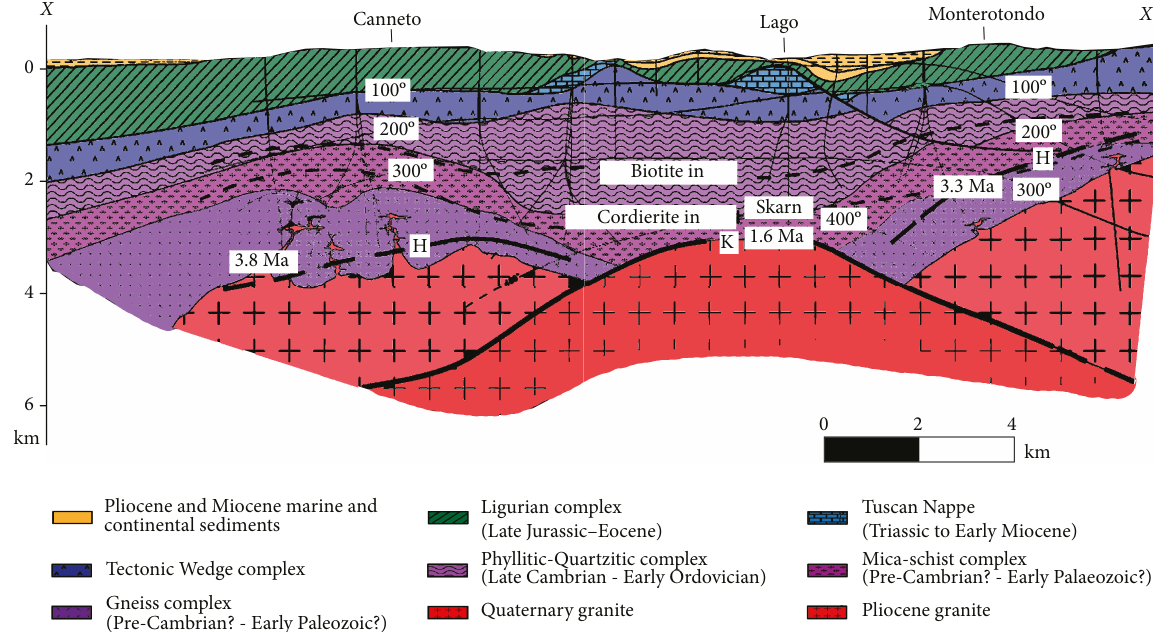
X ′ Monterotondo LagoCanneto X